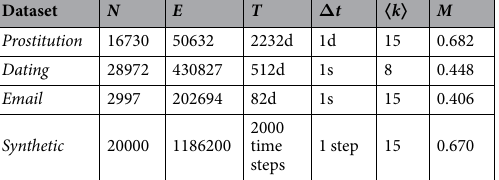
Table 2. Some properties of temporal networks. Number N of different individuals generated E edges during T time steps. Δ t represents time units, 〈 k 〉 represents average degree, M represents modularity of the accumulated networks.